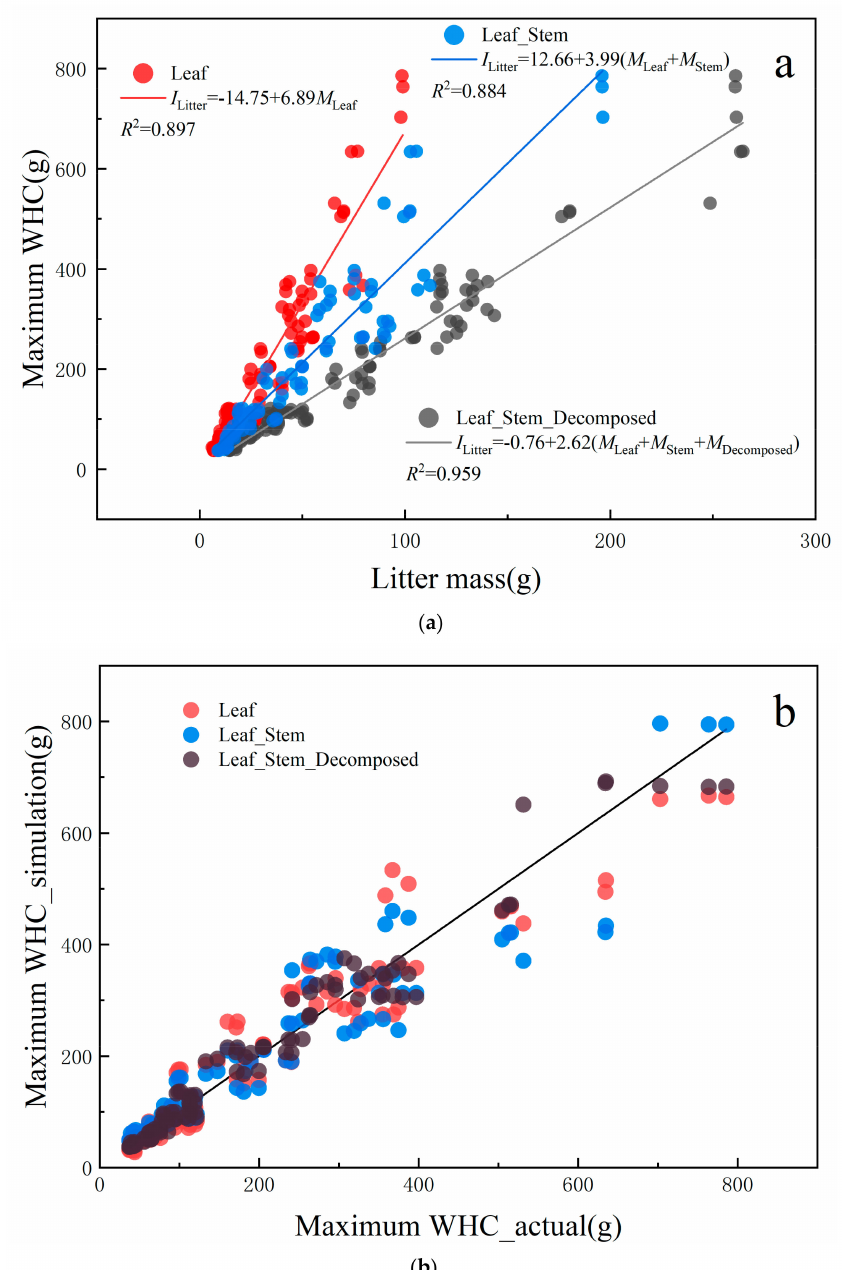
Figure 6. ( a ) Three di ff erent linear models of water-holding capacity (WHC). ( b ) The comparison between the observed value and the estimated value of the three models of